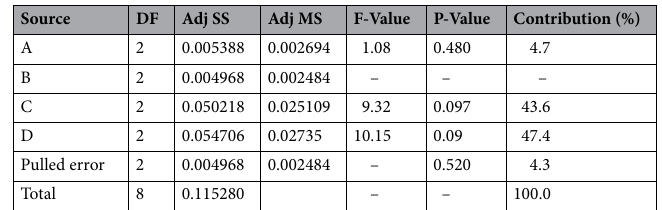
Table 10. Response of variable parameters of GRG.